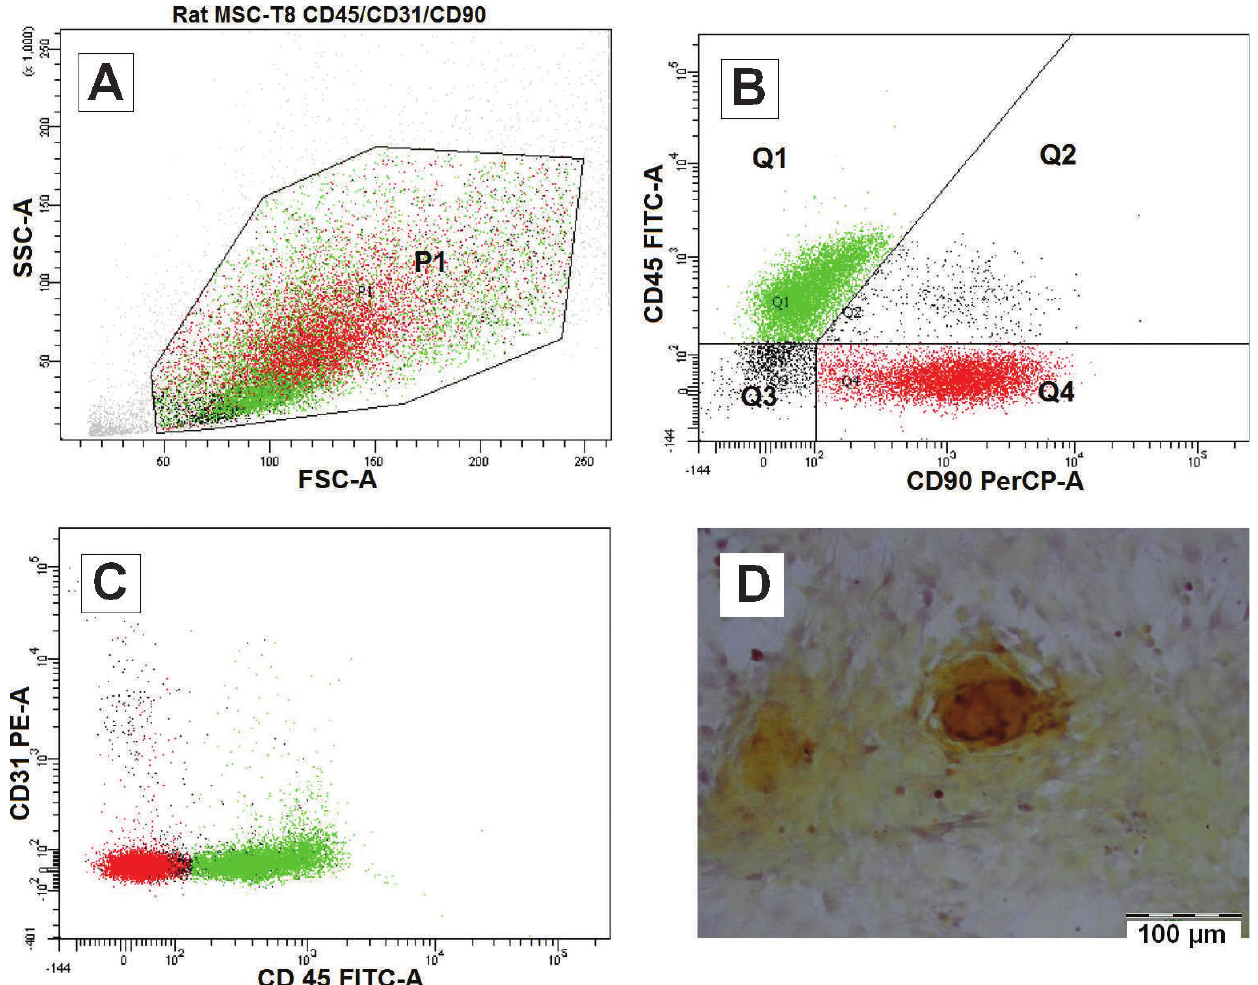
Figure 4 - Characterization of isolated cells from rat bone marrow after passage 1. Cells were analyzed with BD FACSDiva software (A, B and C). The P1 population (A) was divided into four quartets, of which 48.3% were Q1:CD31-/CD45 + /CD90- and 41.1% were Q4:CD31-/ CD45-/CD90 + , which are indicated in green and red, respectively (B and C). Alizarin Red S staining of separate isolated cells has demonstrated the active deposition of calcified minerals after 14 days of osteogenic medium